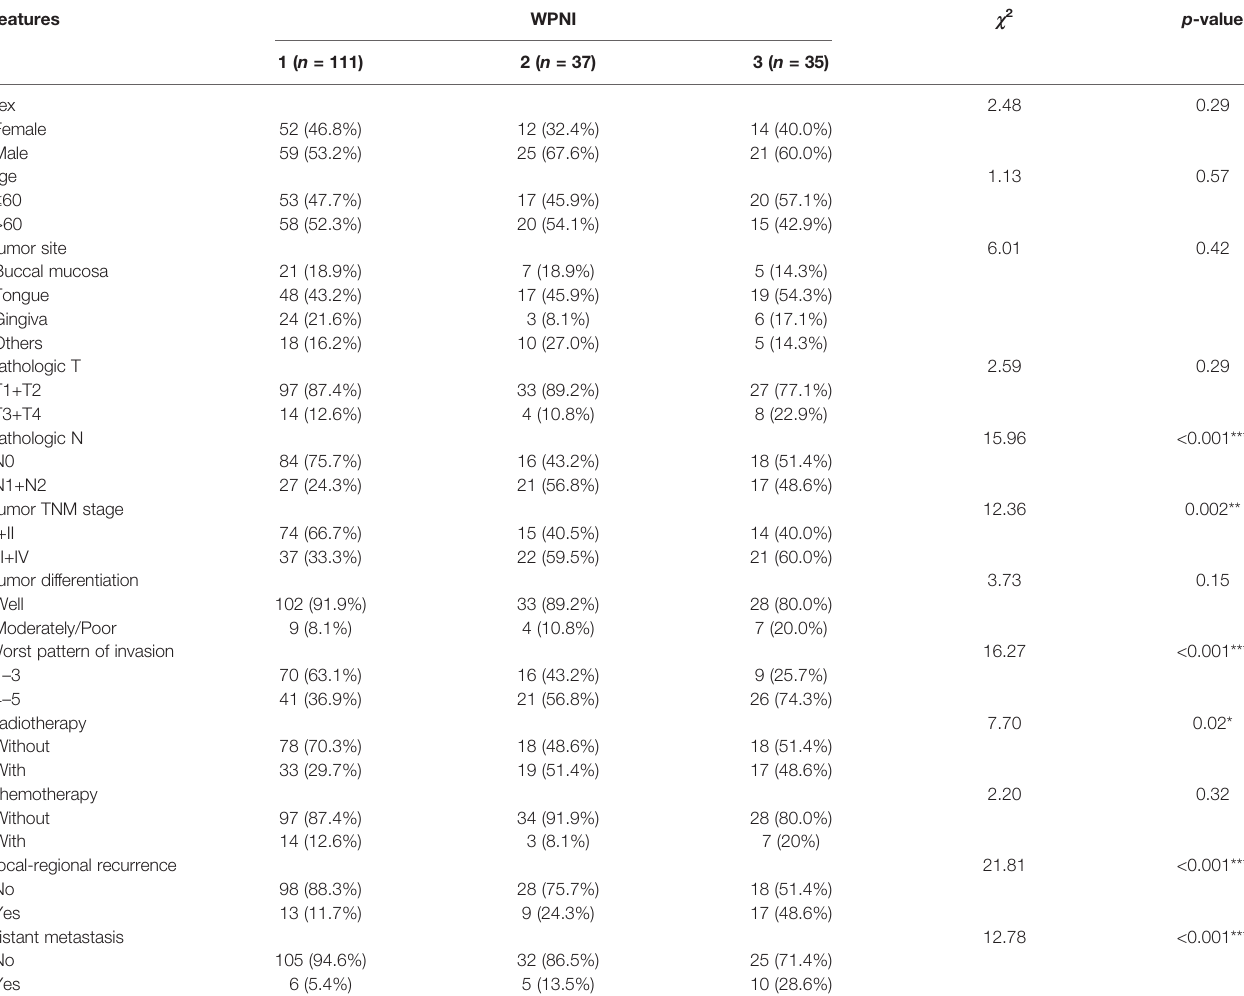
TABLE 2 | Clinicopathological features and their associations with the WPNI scoring system.